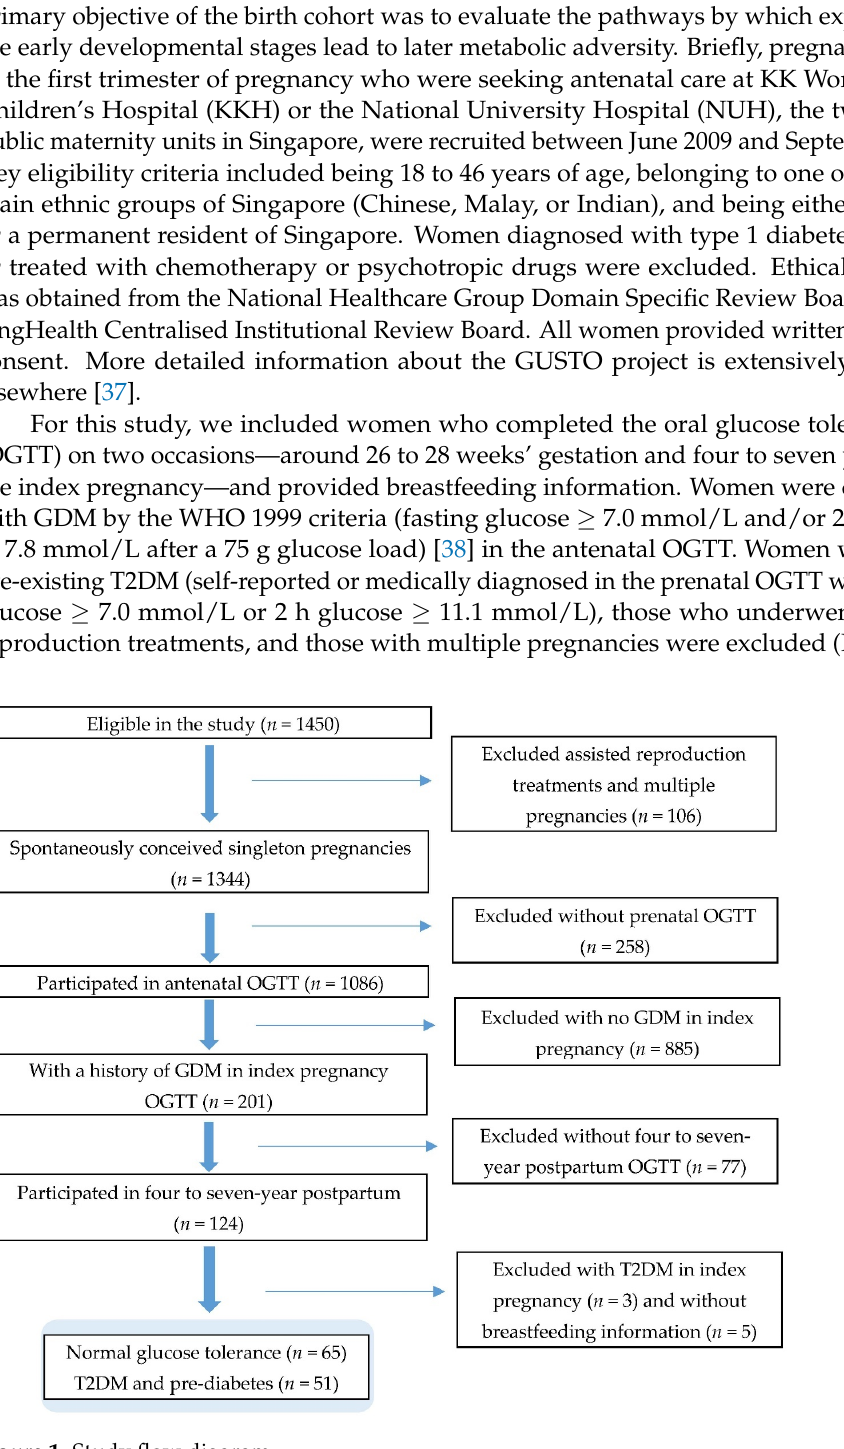
Figure 1. Study flow